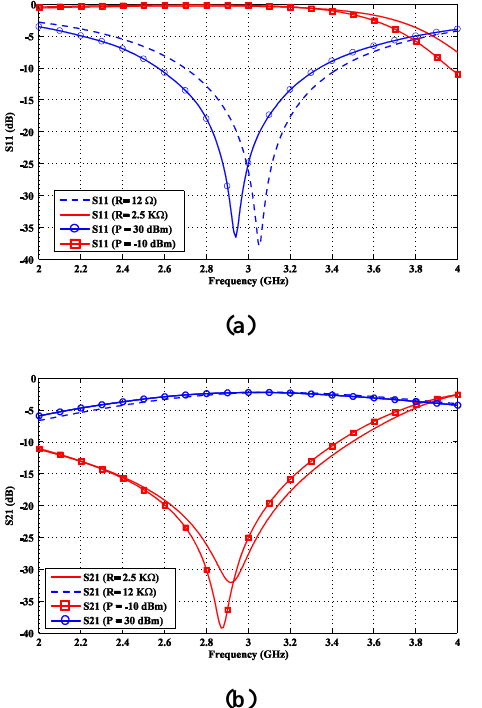
Figure 8: Comparison of S11 (a) and S21 (b) result from full wave and nonlinear